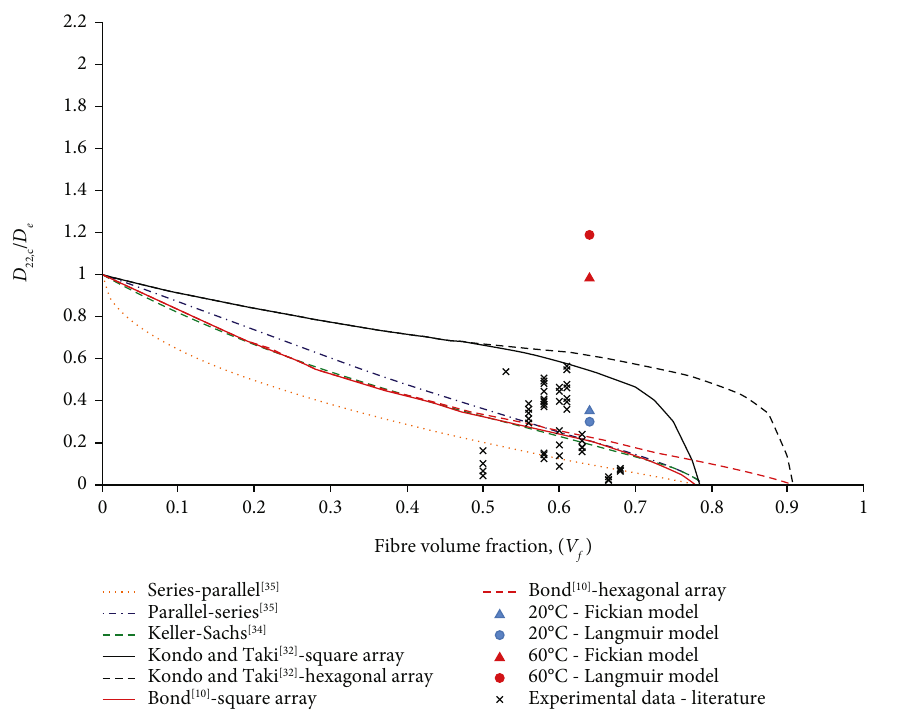
Figure 6: Calculated values of transverse di ff usivities compared to fi ndings in the literature.